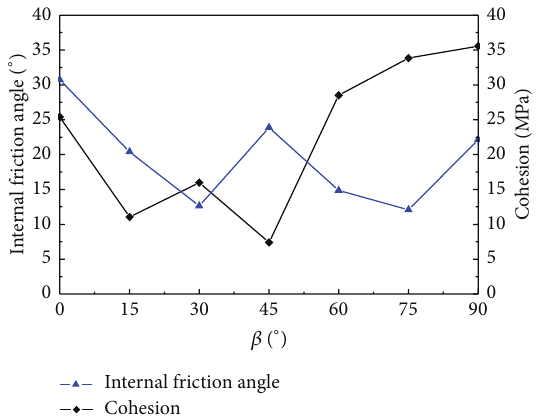
Figure 8: The friction angle and cohesion at various orientation angles were determined by plotting the linear Mohr-Coulomb fail- ure envelopes. Figure 9: Tangent Young’s modulus versus